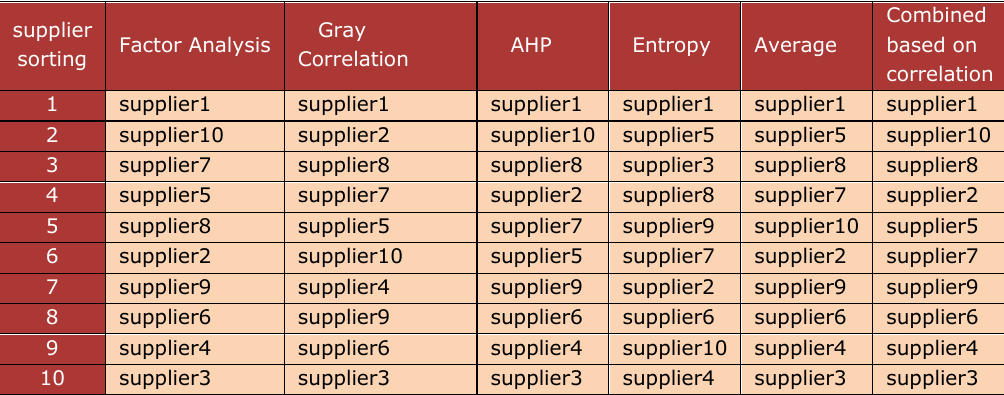
Table 3. Contrast of Supplier evaluation